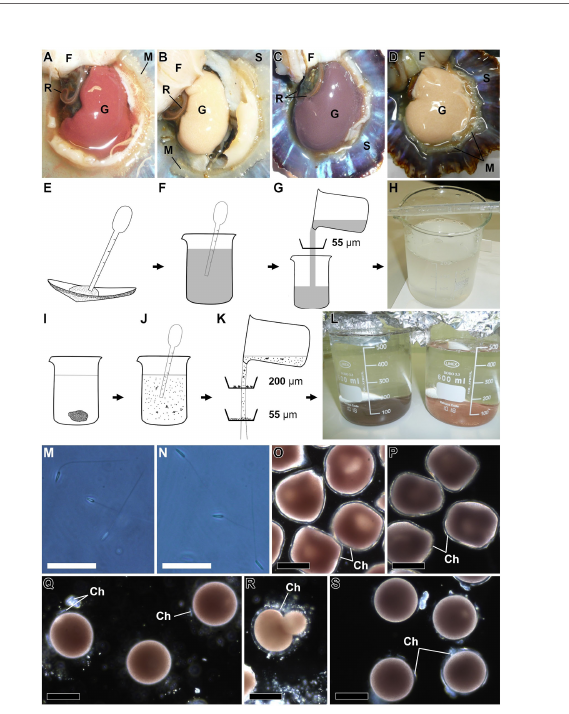
FIGURE 5 | Method for obtaining the gametes of the limpet species P . aspera and P . candei . Gonad of P . aspera exposed by dissection (A, B) : female (A) and male (B) . Gonad of P . candei exposed by dissection (C, D) : female (C) and male (D) . Method for obtaining the sperm (E – H) : sperm collected using a Pasteur ’ s pipette (E) , dilution of the sperm in seawater (F) , fi ltration (55 µm) of the sperm solution (G) , and example for sperm solution (H) . Method for obtaining the oocytes (I – L) : female gonad inside a glass beaker (I) , oocytes released using a Pasteur ’ s pipette (J) , fi ltration using a 200- and a 55-µm mesh (K) , and example of pool of oocytes of P . aspera (right) and P . candei (left) (L) . Sperm cells (M, N) : P . aspera (M) and P . candei (N) . Oocytes just after the extraction showing polyhedral shape and the chorion membrane (O, P) : P . aspera (O) and P . candei (P) . Oocytes just after the alkaline treatment showing spherical shape and the degradation of the chorion membrane (Q, S) : P . aspera (Q) and P . candei (S) . Oocyte of P . aspera deformed due to the alkaline treatment (R) . Scale bar = 25 µm (M, N) , 100 µm (O – S) . Ch, chorion; F, foot; G, gonad; M, mantle; R, radula; S,